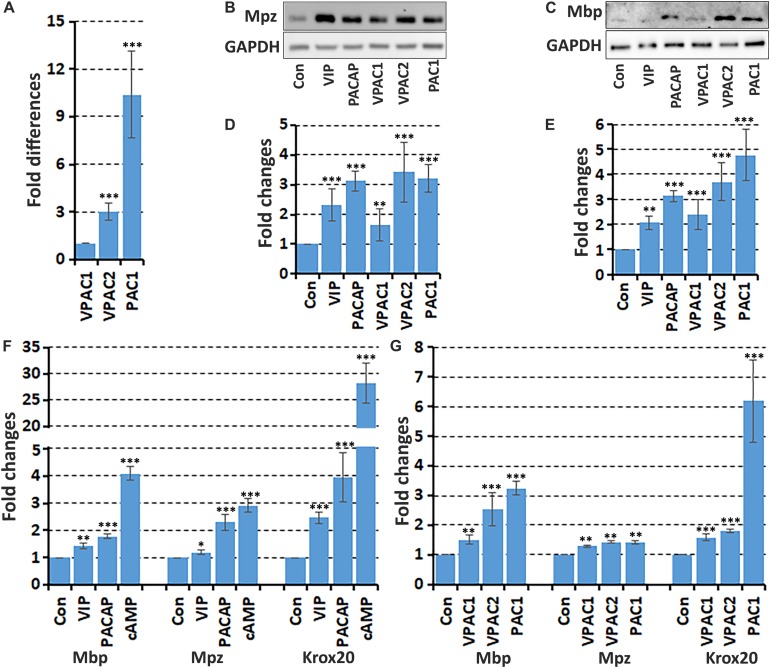
VIP and PACAP increase myelin gene expression in cultured Schwann cells. (A) Relative expression level of VPAC1, VPAC2, and PAC1 in cultured primary rat Schwann cells, n = 3. (B,C) Western blot results show VIP, PACAP and receptor specific agonist up-regulation of myelin protein zero (Mpz) and myelin basic protein (Mbp) protein expression in Schwann cells. (D,E) Quantification of Mpz and Mbp levels from three independent western blot results. (F) qRT-PCR data showing VIP and PACAP increase the mRNA expression of myelinating Schwann cell markers Mbp, Mpz, and Krox20 after 24 h treatment, n = 3. (G) VPAC1, VPAC2, and PAC1 receptor specific agonist treatment increases Mbp, Mpz, and Krox20 mRNA expression in Schwann cells. ∗P < 0.05, ∗∗P < 0.01, ∗∗∗P < 0.001.